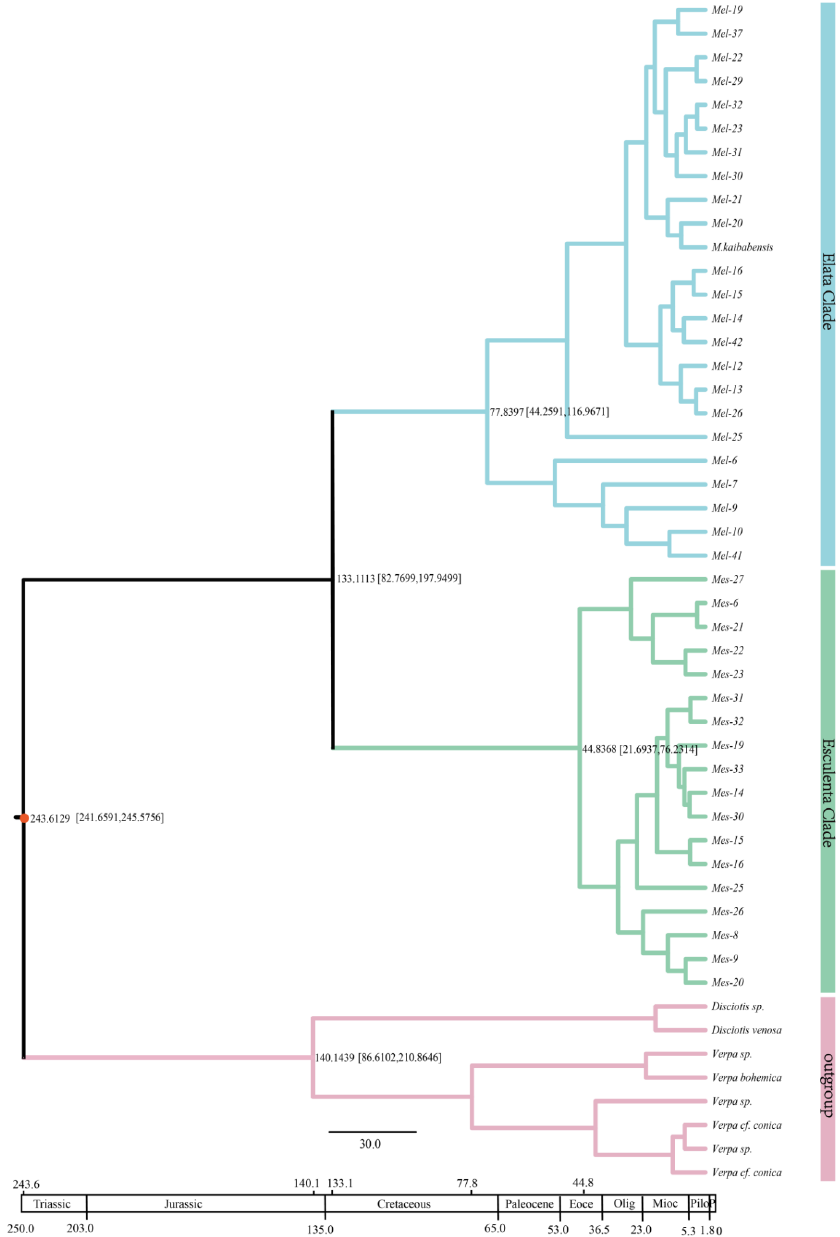
Figure 6. The MCC chronogram is topologically concordant with phylogenies of the Esculenta and Elata Clades that were inferred from the combined three-locus data sets ( EF1- α , RPB1 and RPB2 ). The differentiation time of Morchellaceae was used as the calibration point (O’Donnell, 2011). The color pink stands for the outgroup, Verpa sp. And Disciotis sp.; green represents the Esculenta Clade; and the Elata Clade is shown in blue. The bars of 95 HPD for each divergence are marked on the